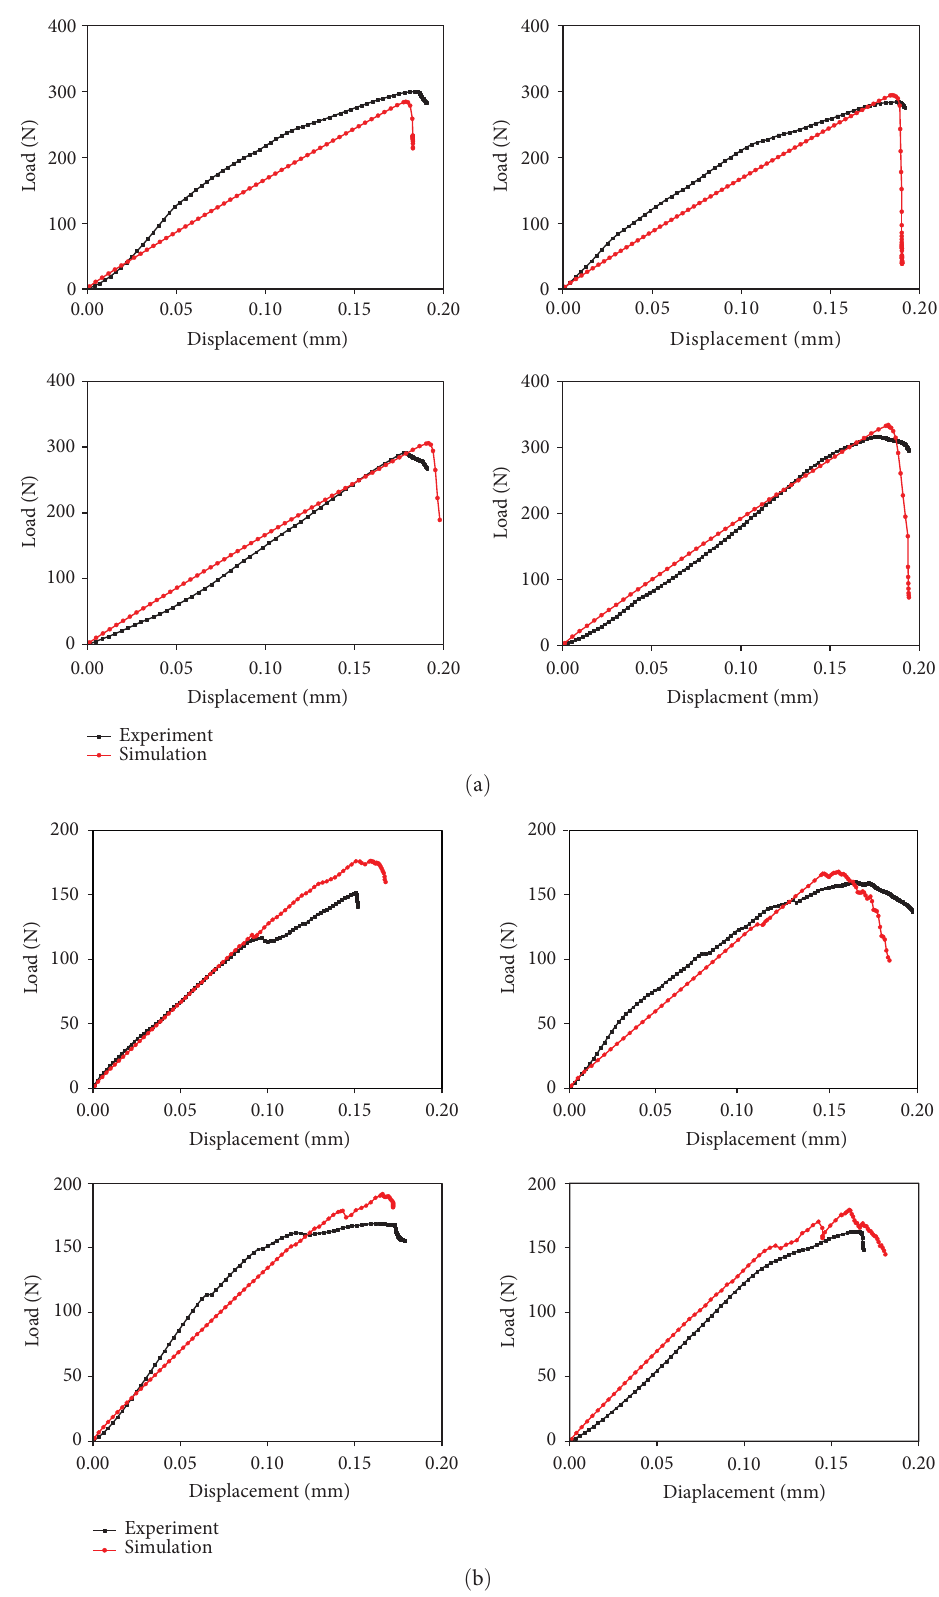
F IGURE 4: Comparison of the load – displacement curves obtained by the fracture simulations and the experiments: (a) comparison of the predicted and experimental load – displacement curves under compression; (b) comparison of the predicted and experimental load – displacement curves under